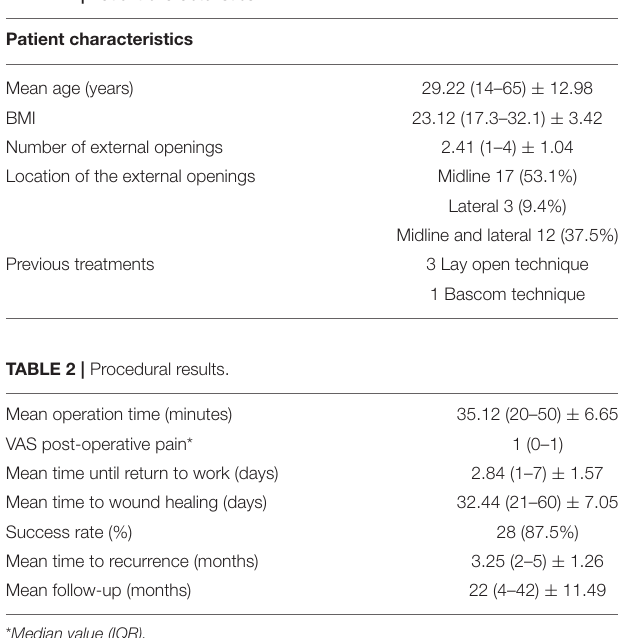
TABLE 1 | Patient characteristics.